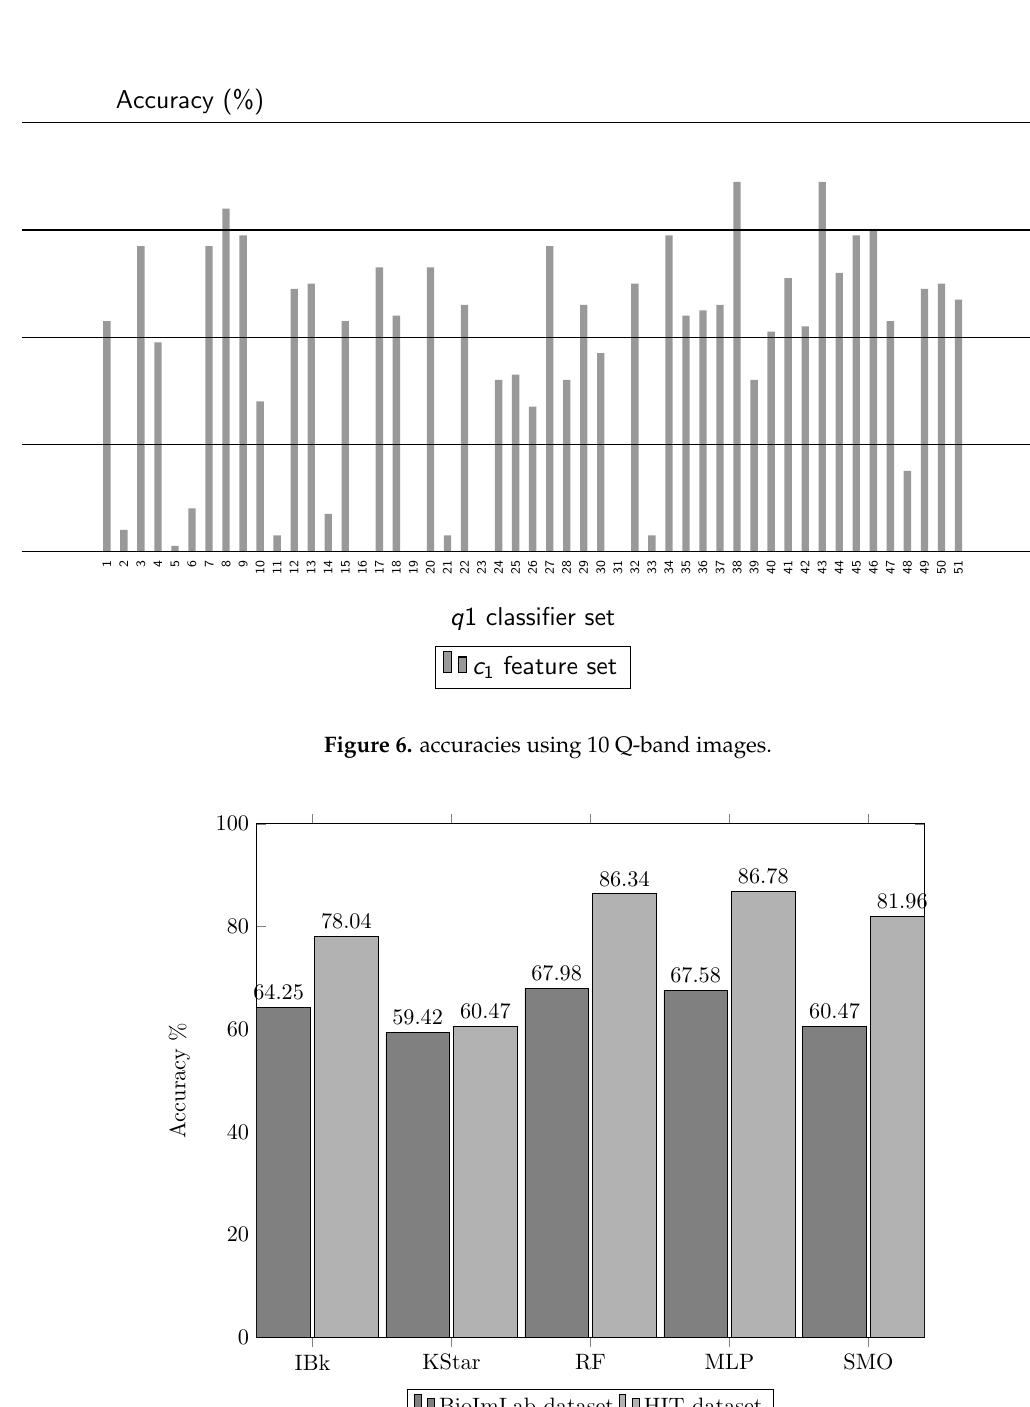
Figure 7. Comparison of accuracies using 10 and 119 Q-band